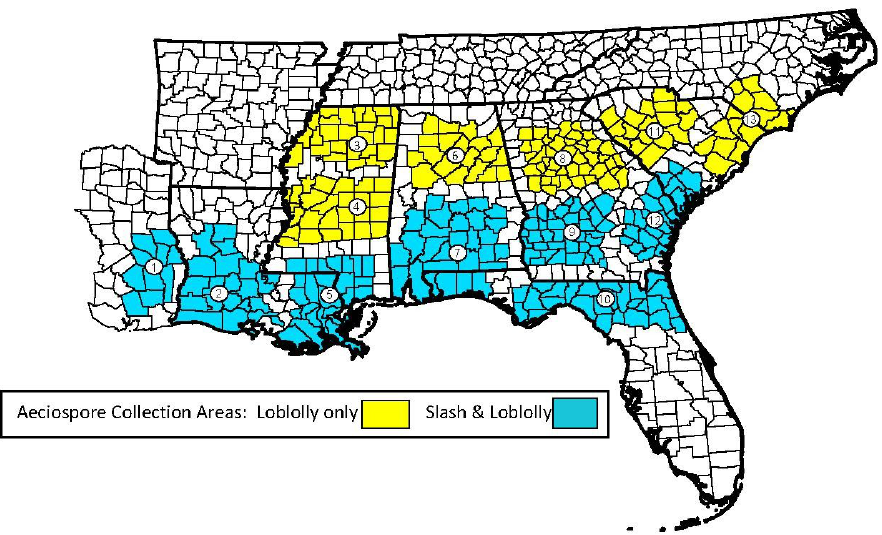
Figure 2. Fusiform rust aeciospore collection areas (established in 1985) for slash and loblolly pine which are currently maintained by the Resistance Screening Center